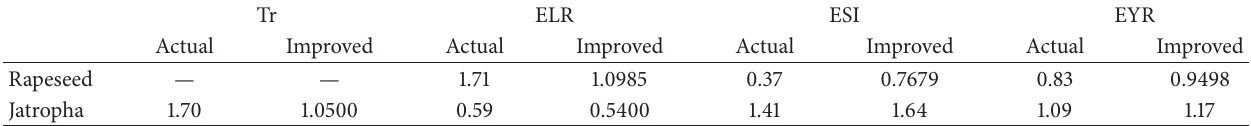
Table 11: Improved objective value of Non-DEA effective crop-based biodiesel system. Tr